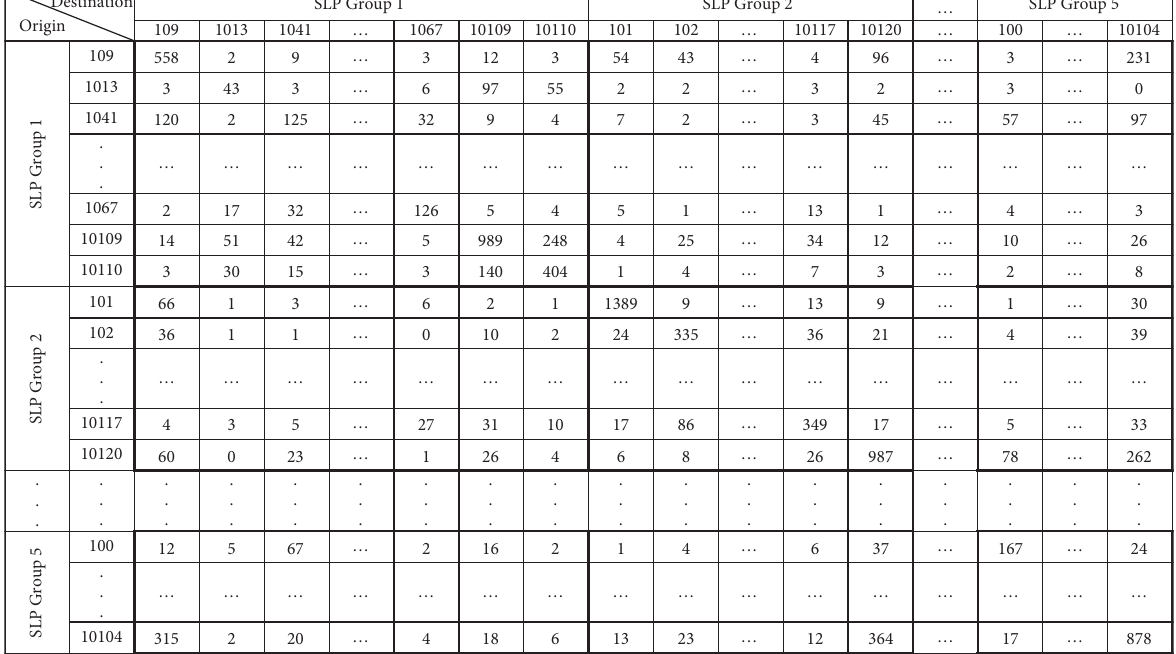
Figure 8: Local windows of SLPSSI in sample Tuesday.